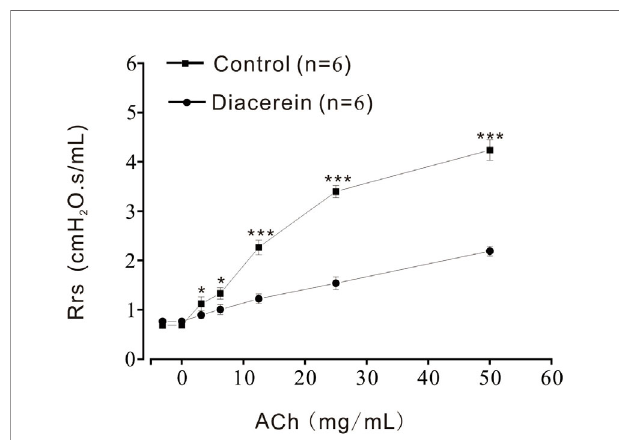
FIGURE 11 | Diacerein inhibited respiratory system resistance (Rrs) increases. ACh-induced increases of Rrs in mice were signi fi cantly inhibited by diacerein (n = 6/6 mice). *, p < 0.05; ***, p